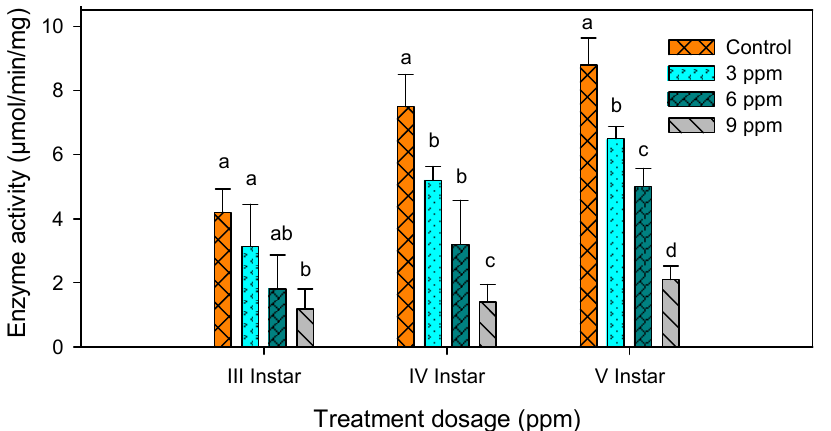
Figure 3. Digestive enzyme amylase activity in third, fourth and fifth instar larvae of S. litura after treatment with andrographolide. The data were fitted on a polynomial (regression) model. Means (± standard error (SEM)) followed by the same letters above bars indicate no significant difference ( p < 0.05) in a Tukey’s test.